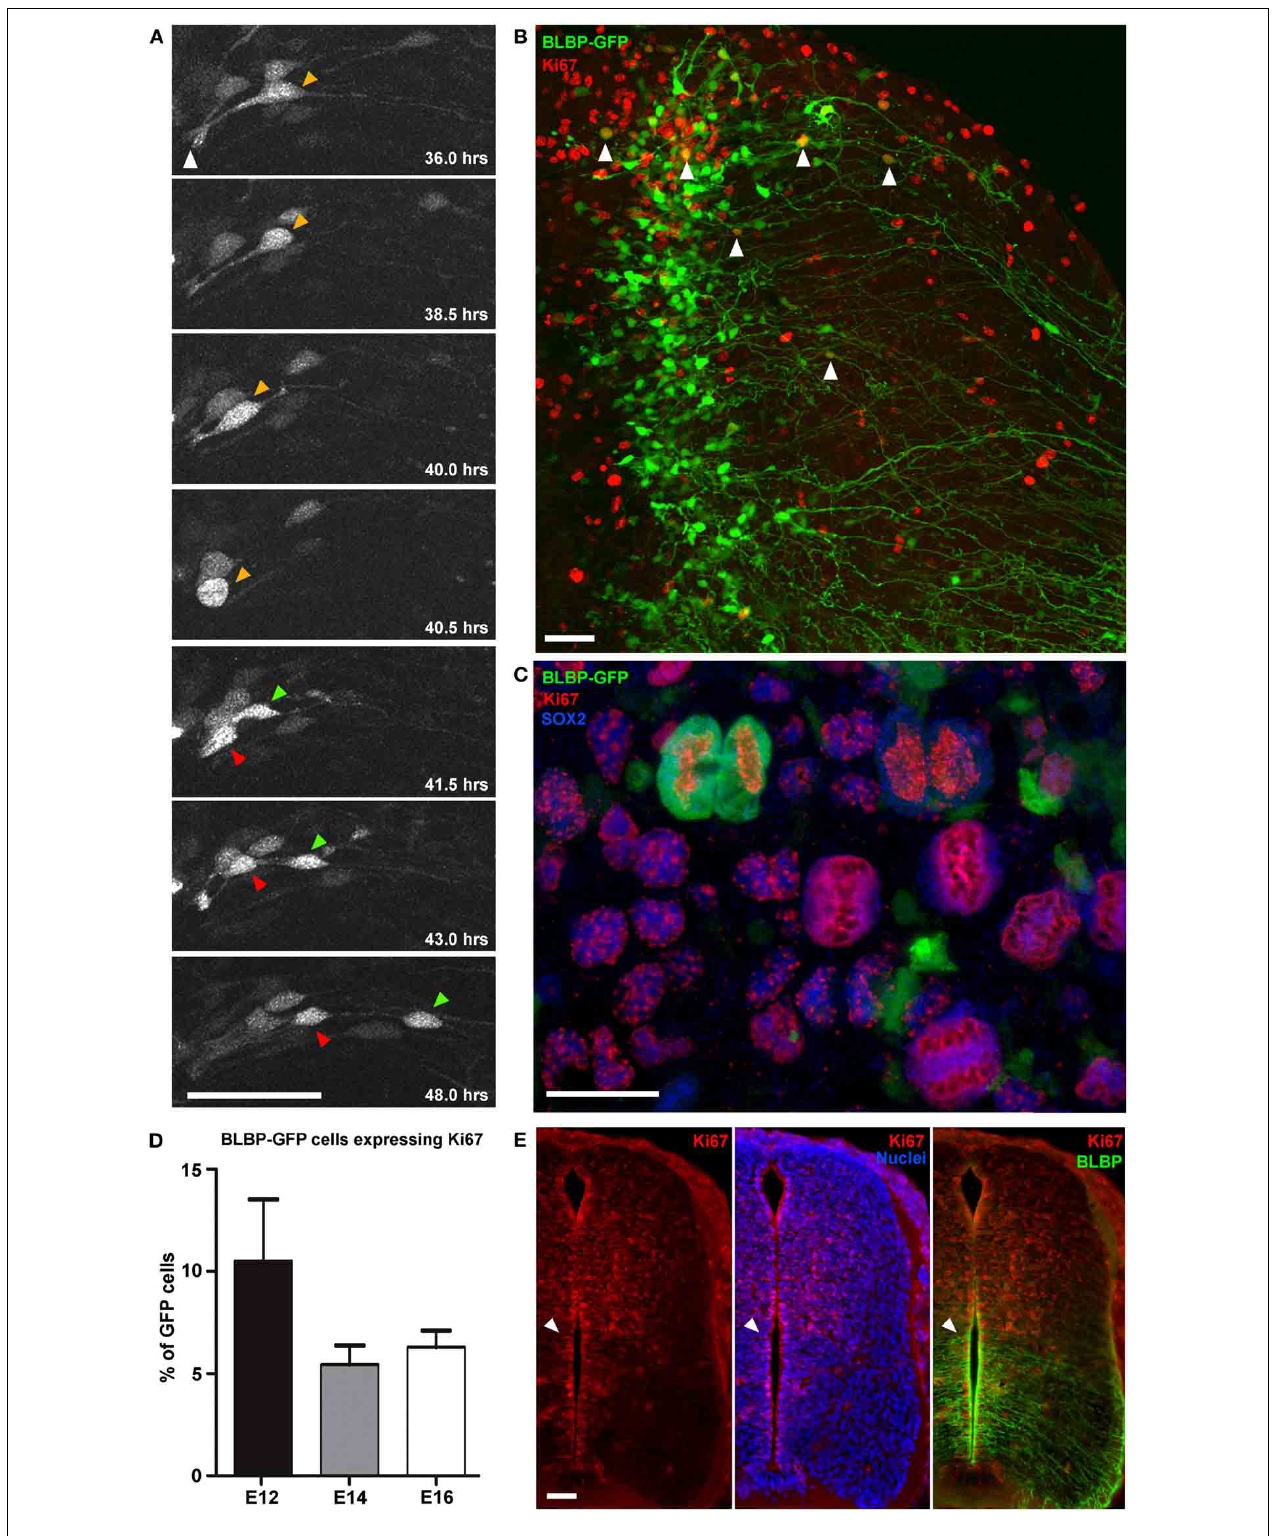
FIGURE 2 | Direct observation of cell division in BLBP-GFP transfected cells. (A) Two-photon image sequence of a GFP-expressing cell in a spinal cord slice undergoing cell division at ∼ 40h after BLBP-GFP transfection at E12. Orange arrow indicates cell before division with apical attachment to the